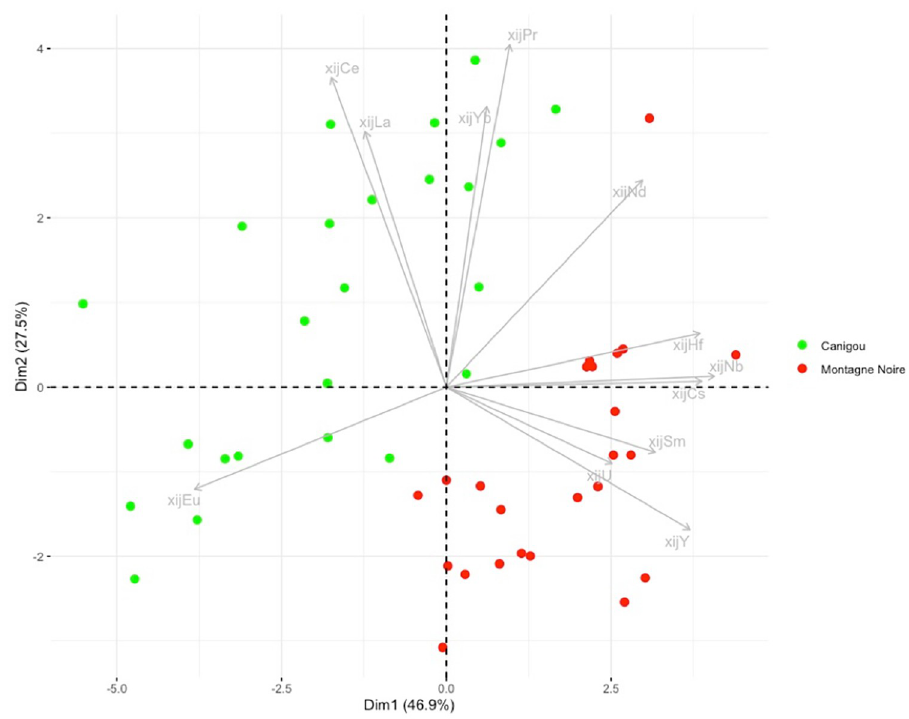
Fig 12. PCA on xij for slag from the Canigou and Montagne Noire production areas. % between brackets: % of total variance.